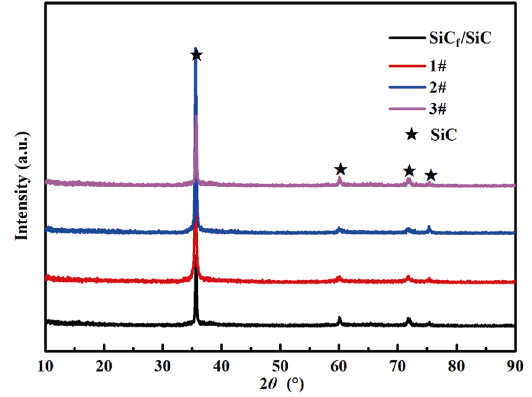
Fig. 2 XRD patterns of as-fabricated composites.